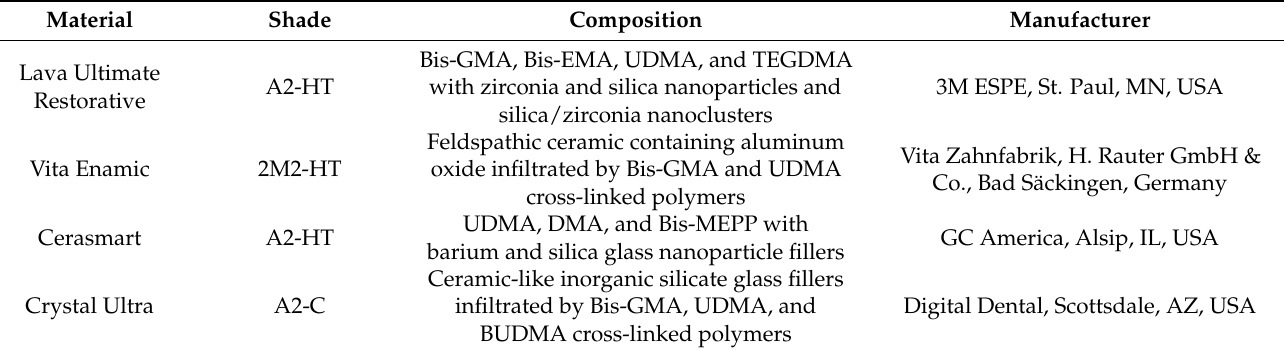
Table 1. CAD/CAM ceramics